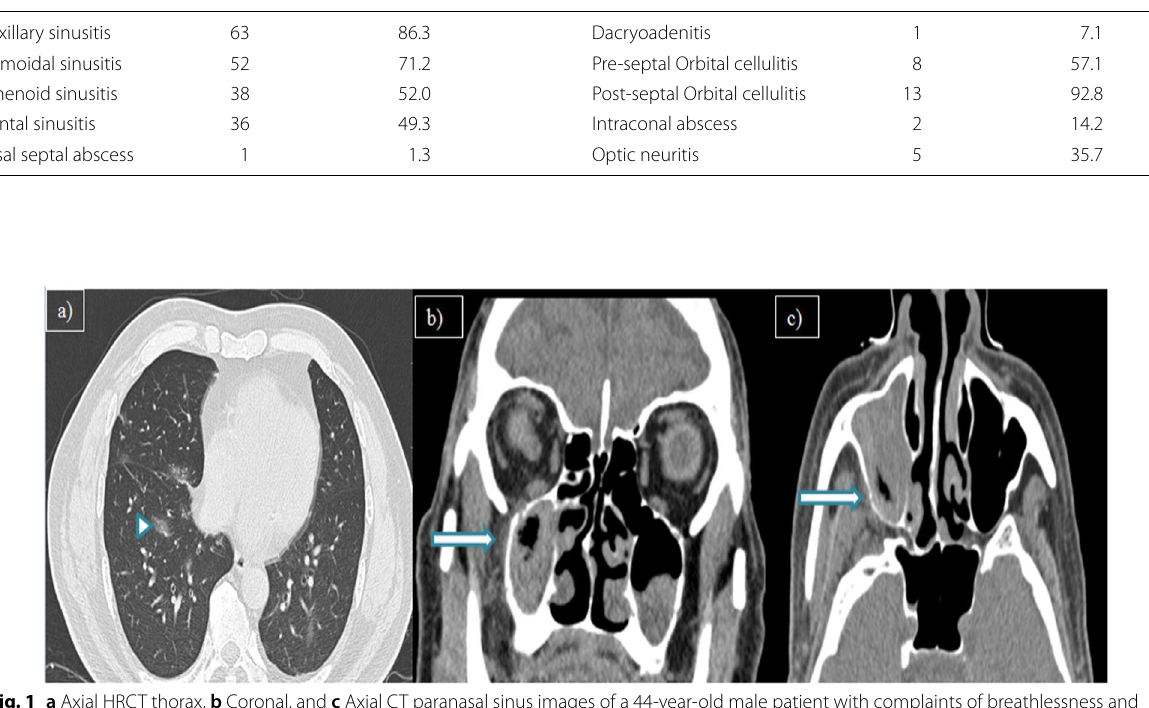
Table 4 Sino-nasal and orbital manifestations of the cohort Sino-nasal Manifestations (out of 73)